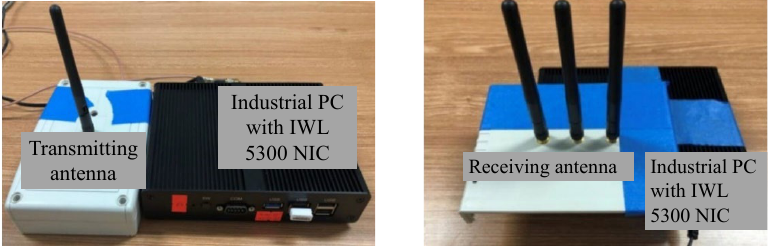
Figure 6. CSI data collection equipment. The mobile terminal has a transmitting antenna ( left ) and the fixed terminal has three receiving antennas ( right ).